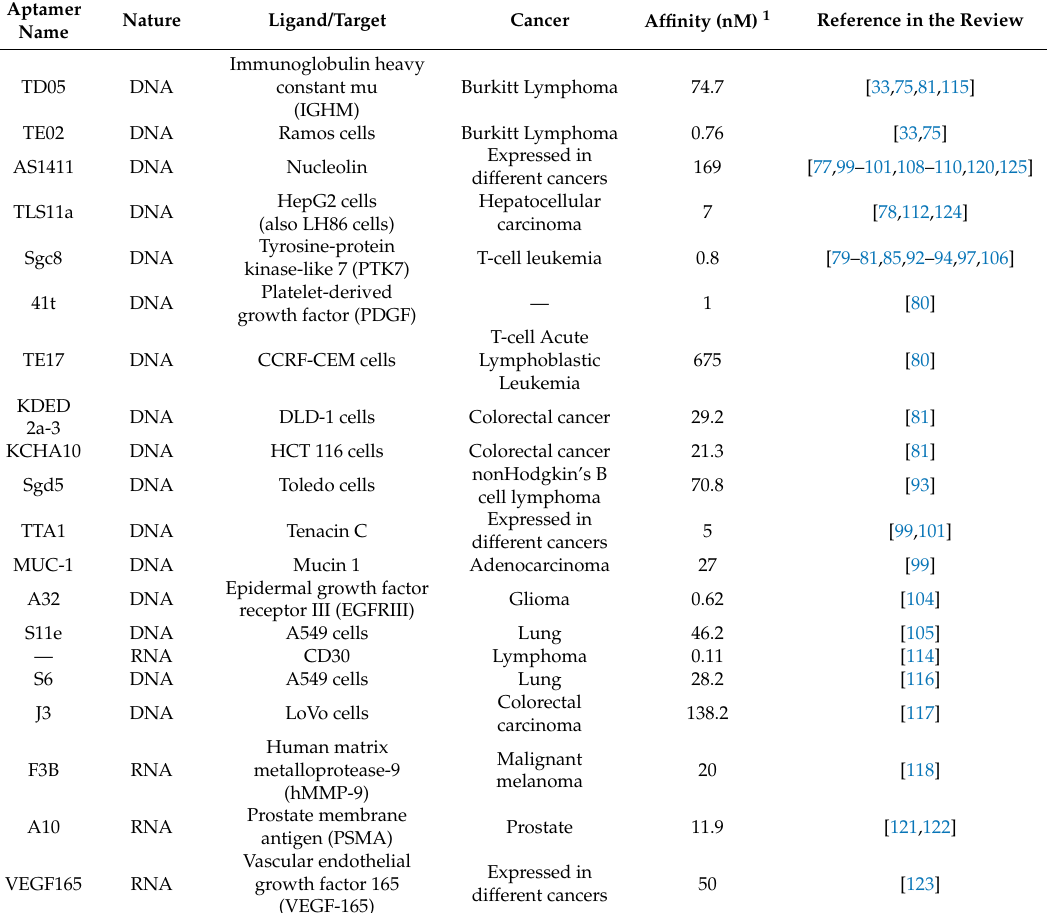
Table 1. A list of reviewed